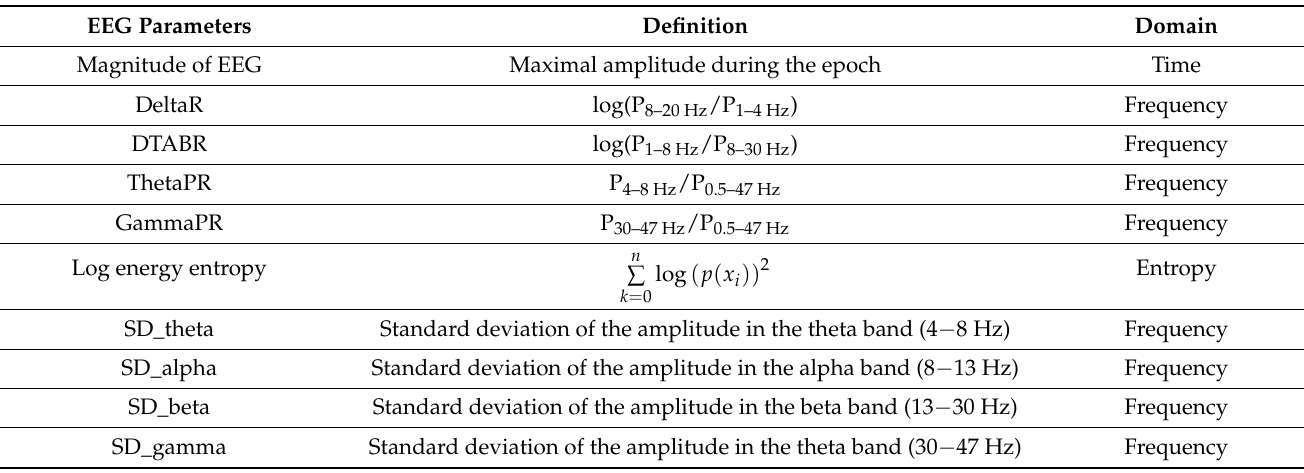
Table A1. EEG Parameters Selected for the Prediction